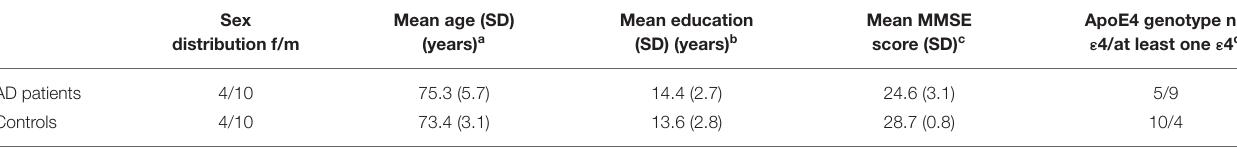
TABLE 1 | Demographic characteristics.